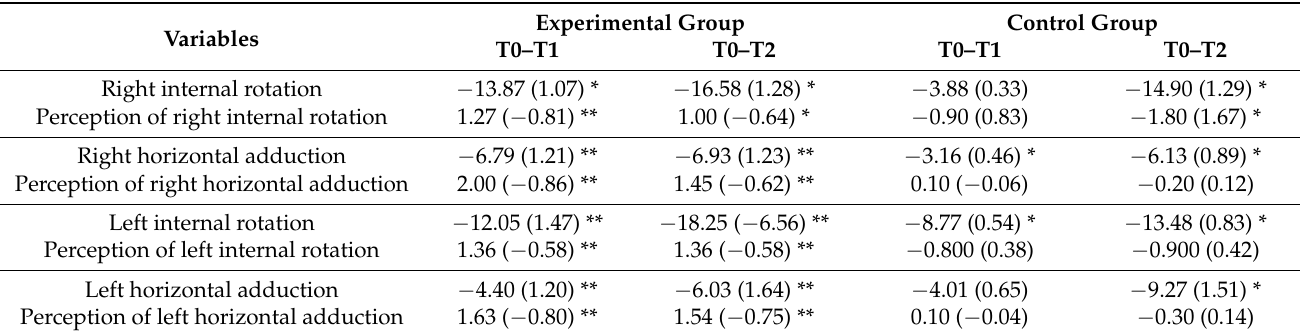
Table 3. Mean difference and changes (and effect size) after post-treatment and follow-up period of the dependent variables of the study with non-parametric Wilcoxon test.